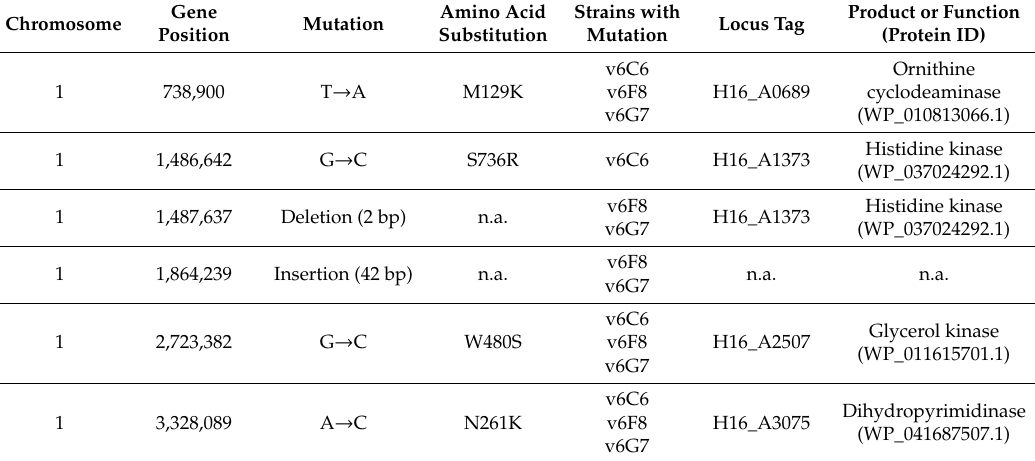
Table 3. Mutations identified in variants v6C6, v6F8, and v6G7. Nucleotide changes were identified by comparison to the sequenced